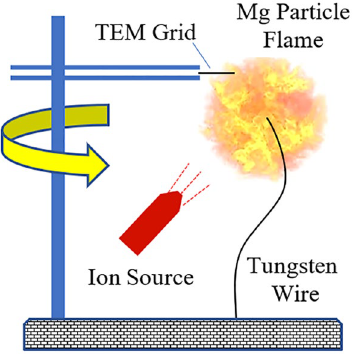
Figure 5. The sketch of the experimental set-up utilized for collection of MgO nanoparticles from a single Mg particle flame.